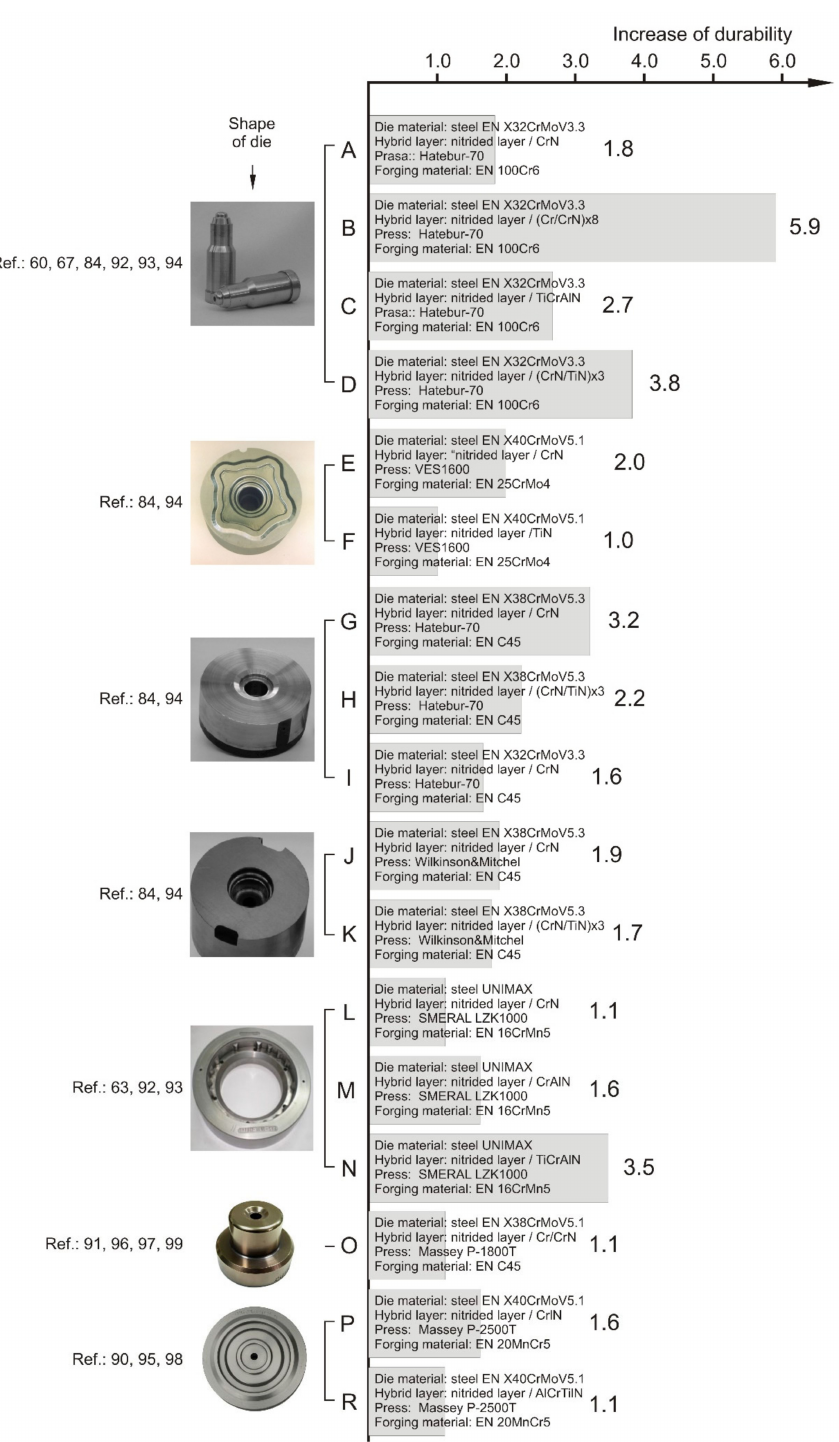
Figure 10. The durability of forging dies in various industrial